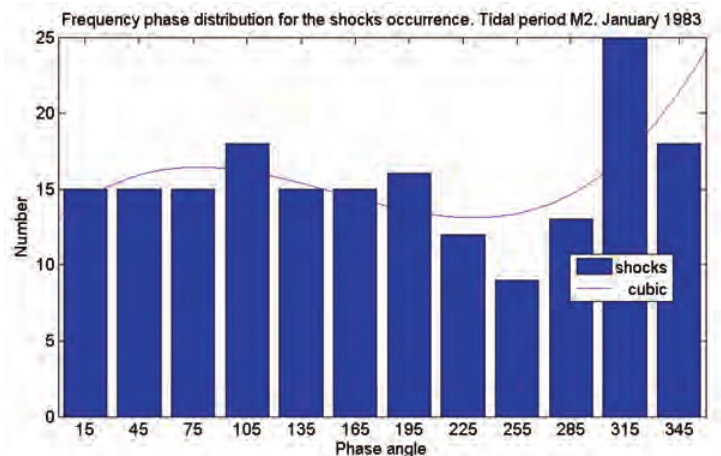
Figure 12. Cumulative histogram corresponding to the tidal period M2 of the 186 events that occurred during January 1983 in the area of Zakynthos.